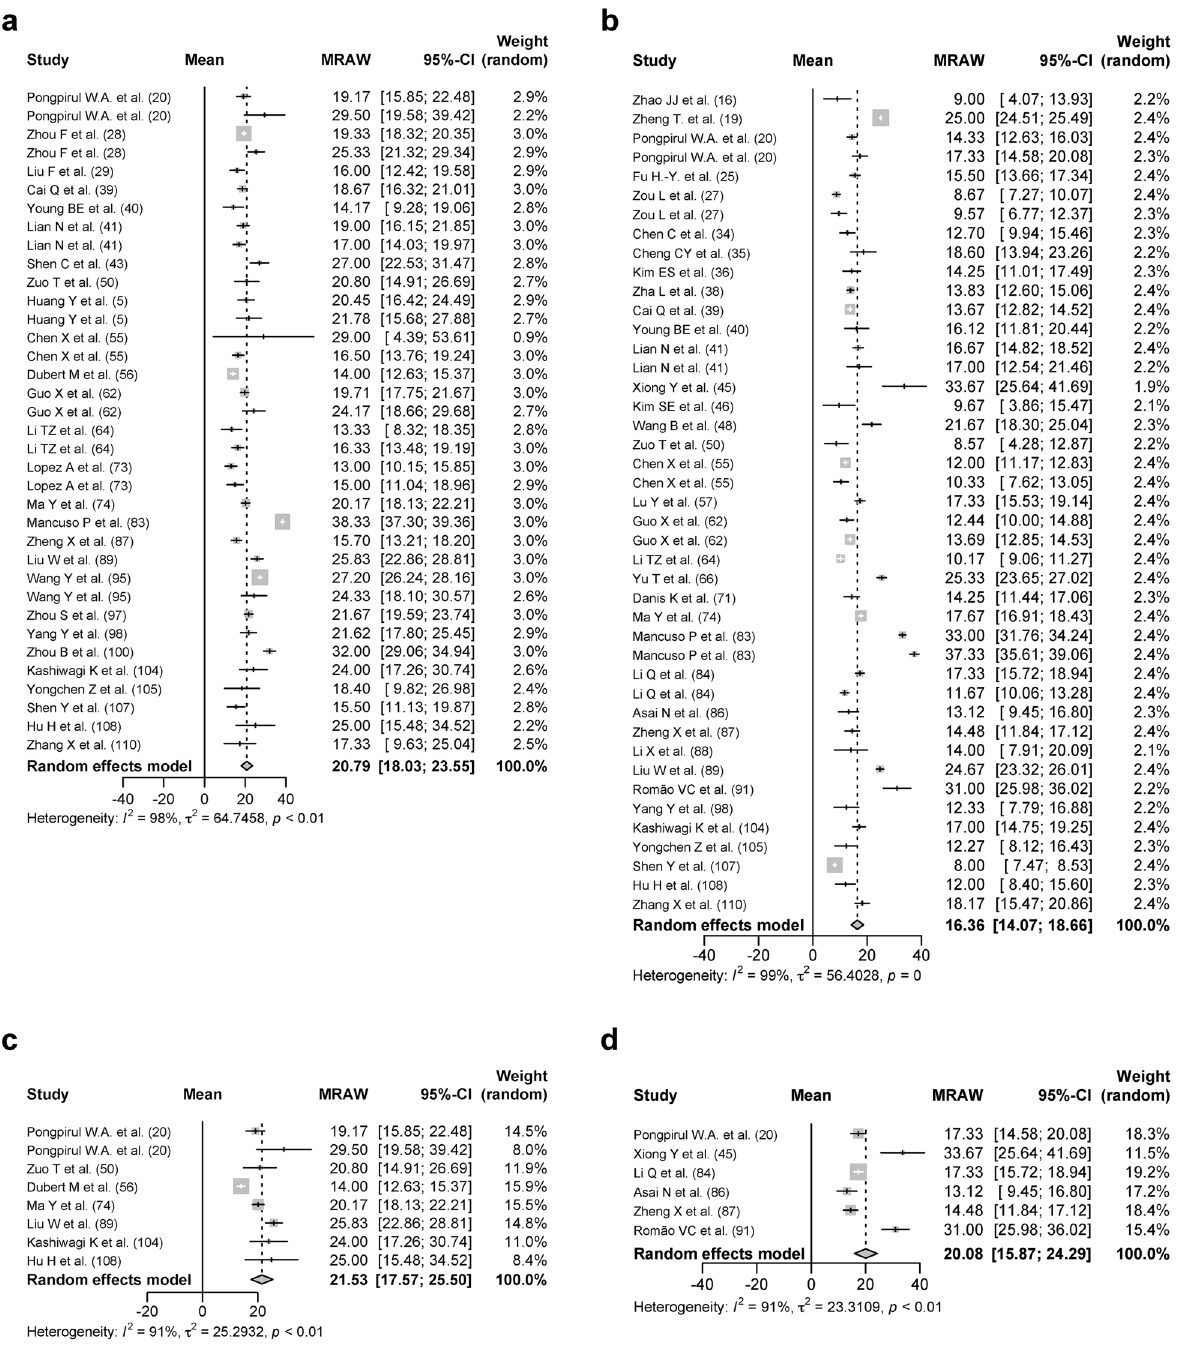
Fig. 7 Forest plot: a meta-analysis of the duration of SARS-CoV-2 RNA positivity in the upper respiratory tract samples based on the severity. The duration of SARS-CoV-2 RNA positivity from the onset of COVID-19 in the severe patients ( a ) and the nonsevere patients ( b ) was calculated using the random effects model. The duration of SARS-CoV-2 RNA positivity from the onset of COVID-19 in the severe patients ( c ) and the nonsevere patients ( d ) from the studies with the mean age of 40 years or older and the proportion of patients with any comorbidities of 30% or more was calculated using the random effects model. MRAW, the raw data of mean; 95%-CI, 95% confidence